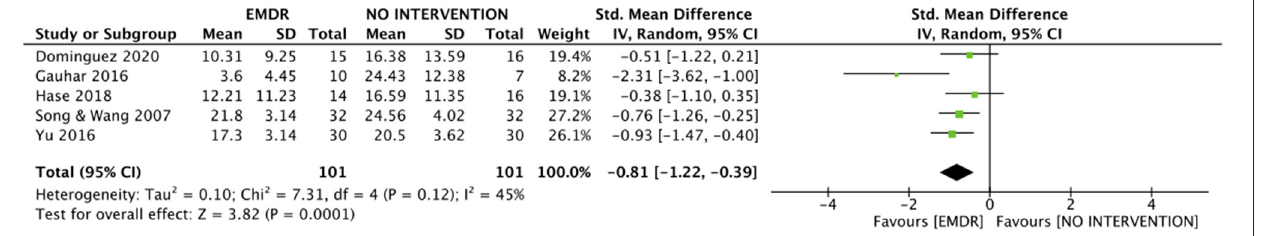
FIGURE 4 | Forest plots of meta-analyses EMDR vs. “No Intervention” control on severity of MDD. EMDR, eye movement desensitization, and reprocessing. MDD, major depressive disorder.